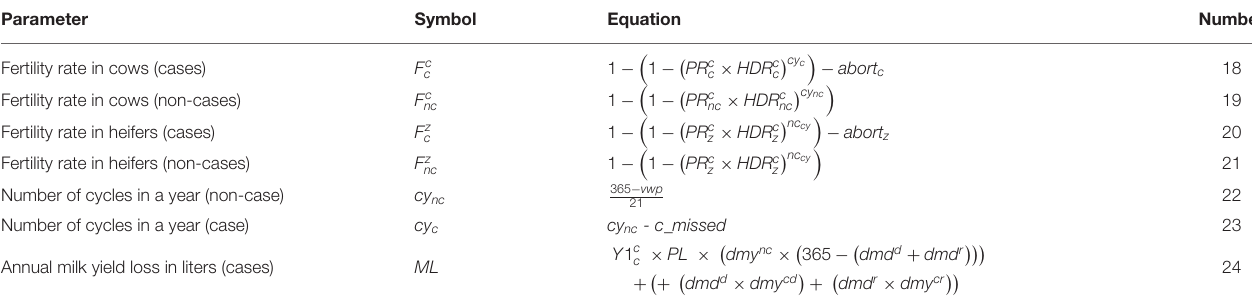
TABLE 3 | Equations for calculating fertility and milk yield parameters. See Table 2 for an explanation of the symbols. Parameter Symbol Equation Number Fertility rate in cows (cases) Fertility rate in cows (non-cases)